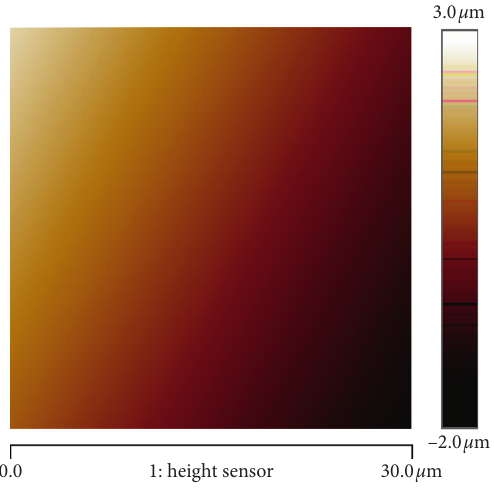
Figure 8: Nanomorphology of #70 matrix asphalt +30% activated Buton rock powder.